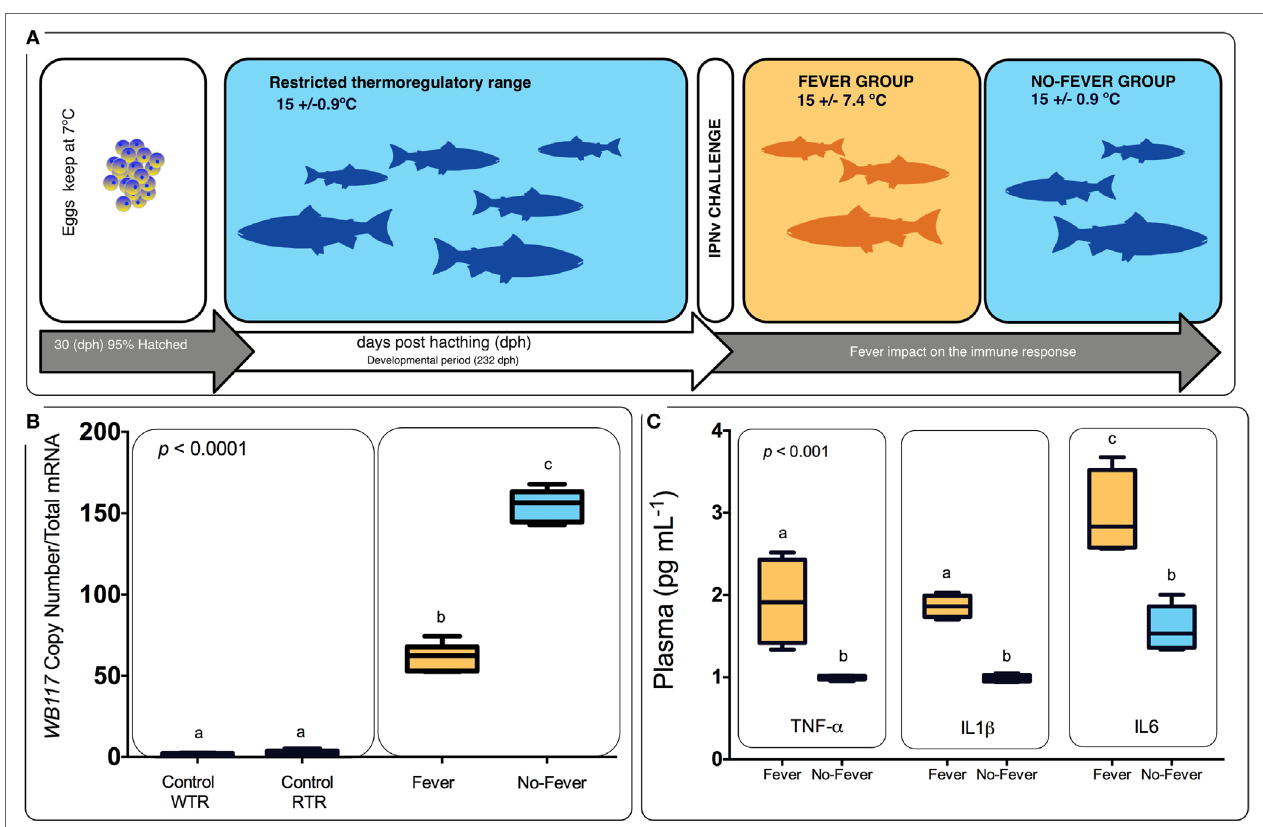
FigUre 1 | Experimental design. (a) Experimental design diagram showing thermal treatments after viral challenge. Temperature treatments are color-coded; blue represents the restricted (no fever group Δ T 0.9°C) and orange represents the wide range (fever group, Δ T 7.4°C). Experimental groups were (i) virus infected with infectious pancreatic necrosis virus (IPNv) (10 × 10 5 PFU/mL − 1 ) by immersion under constant normothermic (preferred temperature) conditions (no fever), (ii) virus infected with IPNv (10 × 10 5 PFU/mL − 1 ) by immersion in a temperature gradient (fever), (iii) control with no gradient (control RTR), and (iv) control in a temperature gradient (control WTR). (B) IPNV viral load during behavioral fever. Mean and SE of IPNV copy number per nanogram total RNA for the WP2 IPN viral segment. Box and whiskers plots registered differences in mRNA abundances between control and viral challenged individuals. (c) Indirect ELISA detection of proinflammatory cytokine release on the plasma in response to IPNv challenge. Box and whiskers plots registered differences between the unlike thermal group. Significance symbols correspond to the p -values for two-way ANOVA test between the different individuals. Unlike letters denote significantly different mRNA levels between the